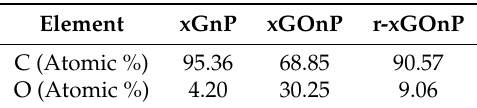
Table 3. Atomic percentage of the principal elements present in xGnP, xGOnP, and r-xGOnP, obtained by the analysis of the EDS